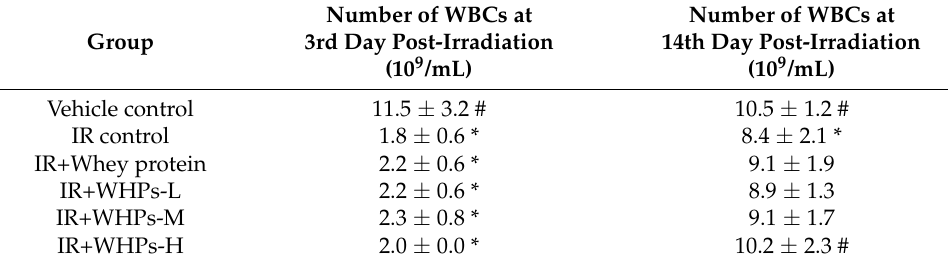
Table 6. Effect of WHPs on white blood cell (WBC) count ( n = 12, x ± s).